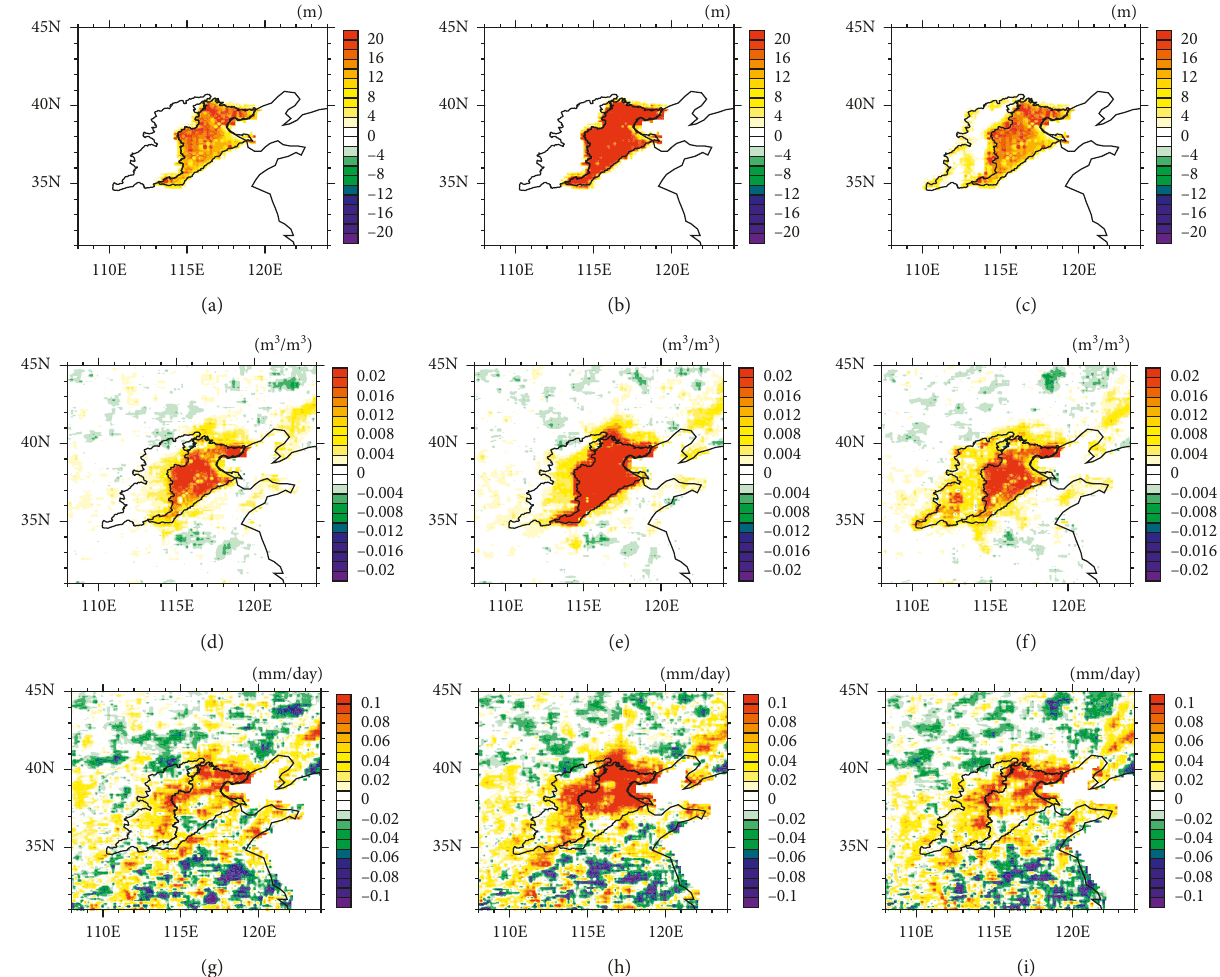
Figure 5: Spatial distributions of groundwater depth difference between tests (a) T1 − CTL, (b) T2 − CTL, and (c) T3 − CTL. Mean soil moisture difference at 10 cm depth for (d) T1 − CTL, (e) T2 − CTL, and (f) T3 − CTL. Mean precipitation difference for (g) T1 − CTL, (h) T2 − CTL, and (i) T3 −